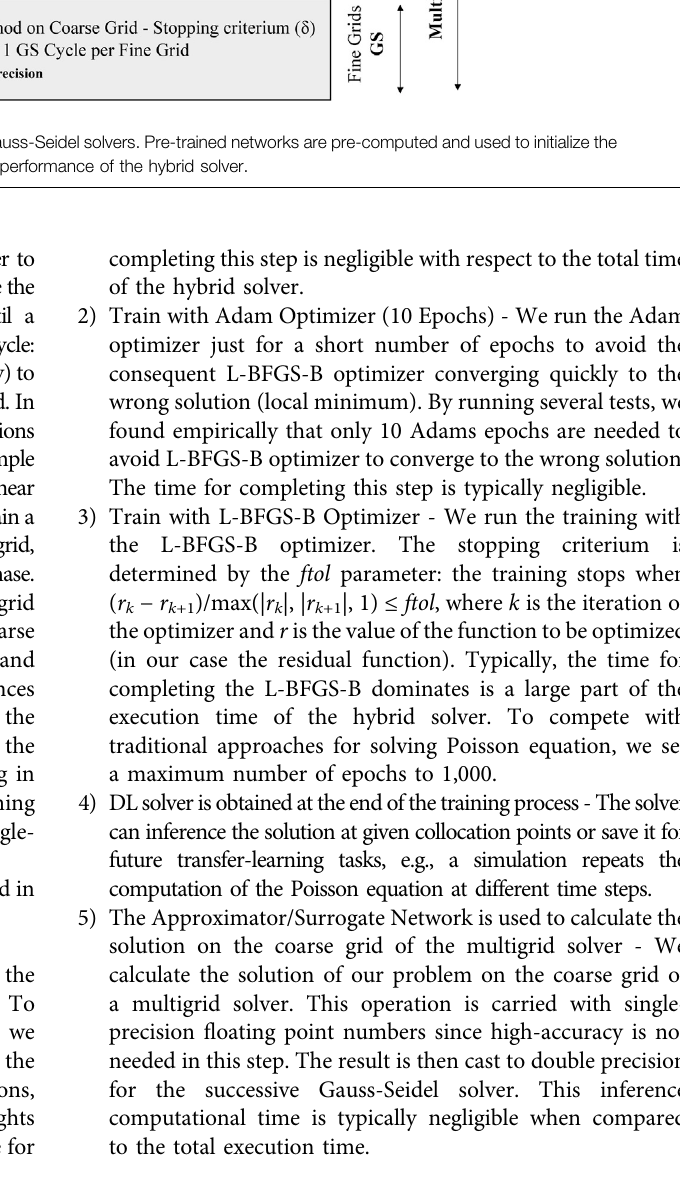
Frontiers in Big Data |